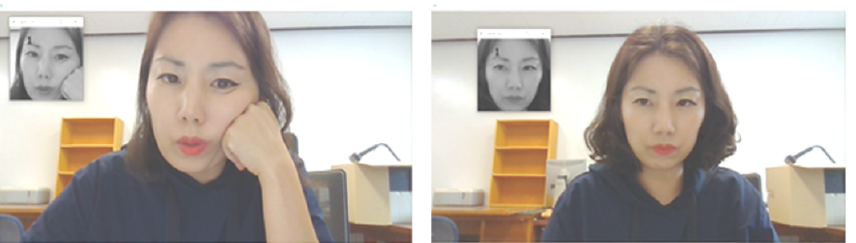
Figure 7. In face detection, the Haar cascade algorithm is employed, and the grayscale image is stored and used as the input for the learning and training